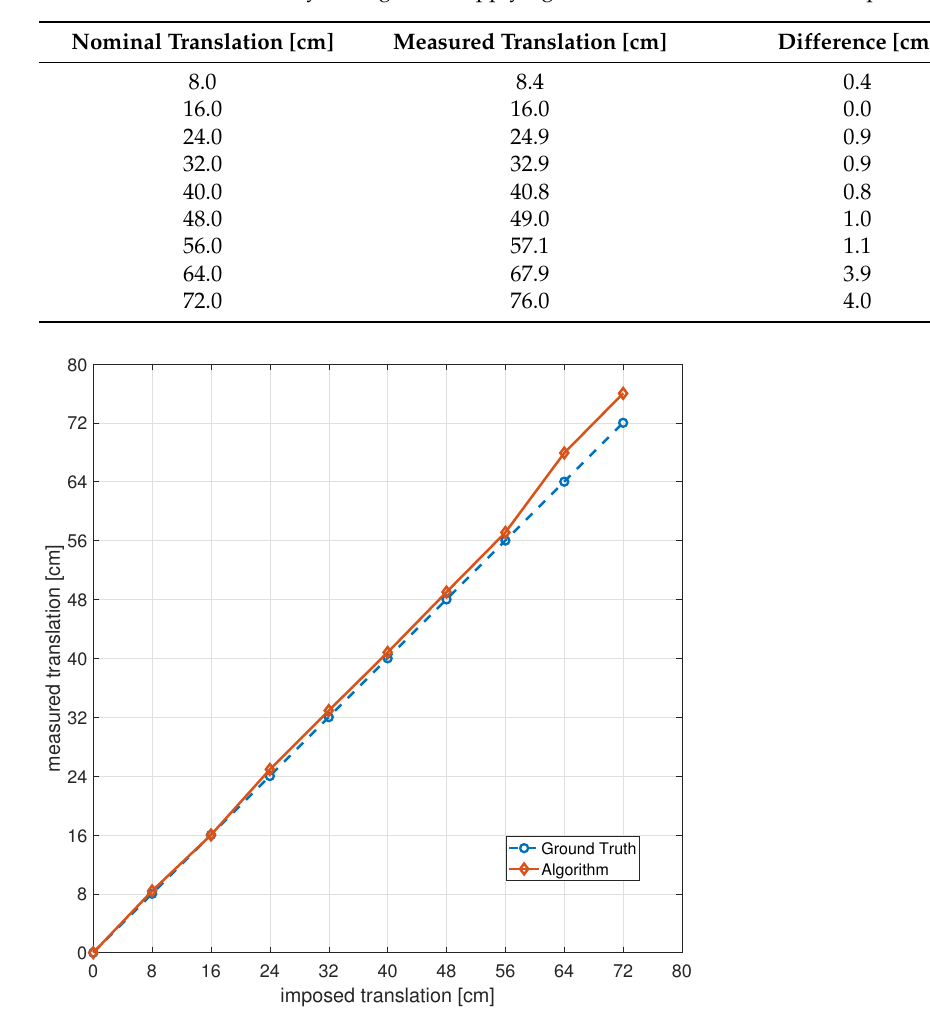
Table 2 and Figure 11 show the results obtained for the imposed translations. Table 2. Results obtained by the algorithm applying a translation of 8cm at each step.